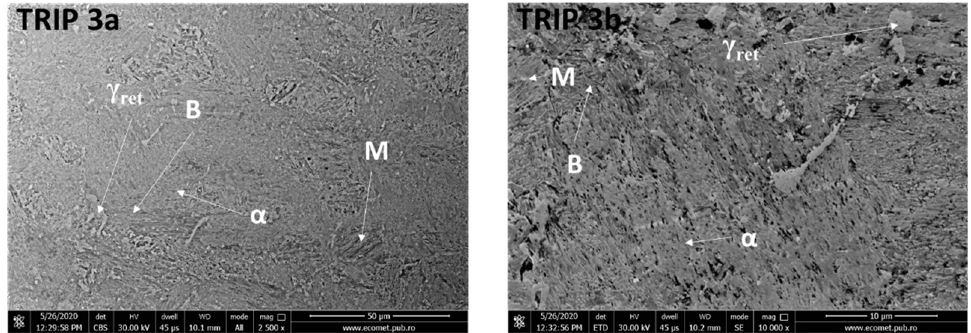
Figure 3. Microstructures (BSE—( a ); SE—( b )) of TRIP 3 after heat treatment.